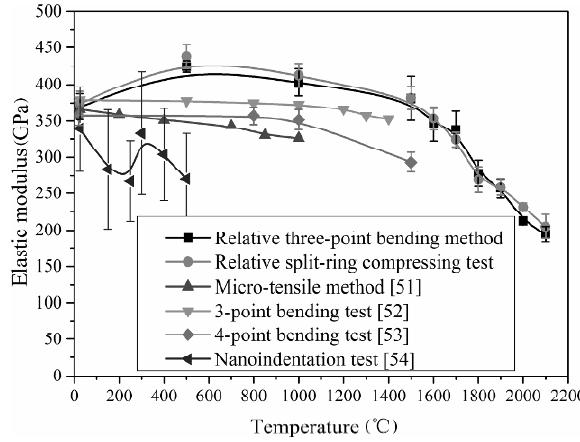
Fig. 10 Measured elastic modulus of SiC coatings from room temperature to HT from this work and other previous related